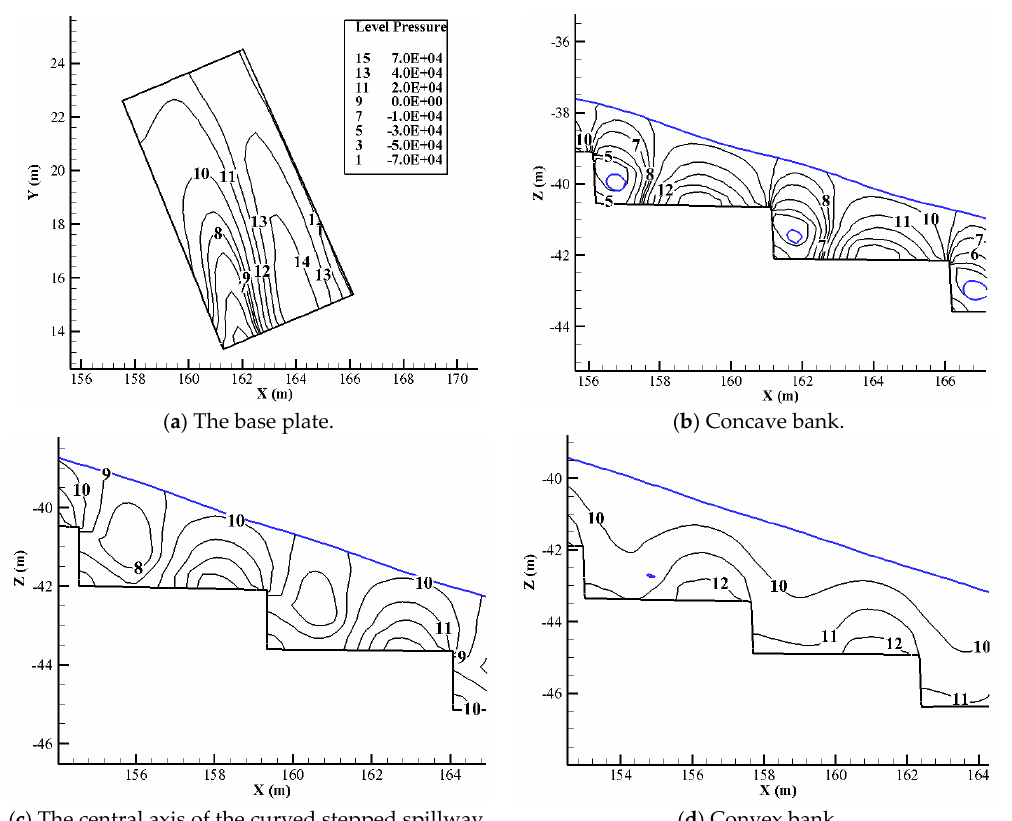
Figure 16. Pressure isolines on step No. 17 (unit: Pa).